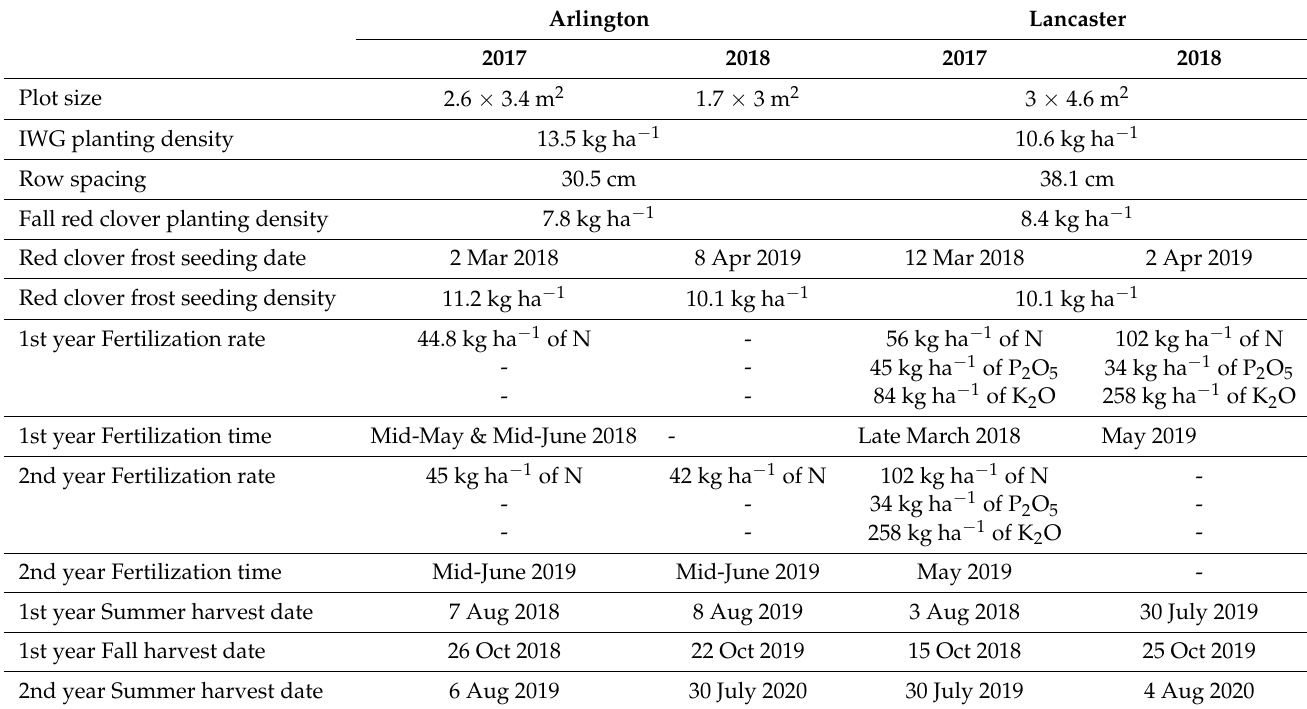
Table 2. Management practices, seeding and harvest dates for the intermediate wheatgrass (IWG) planting date experiment seeded in 2017 and 2018 at Arlington and Lancaster, WI,